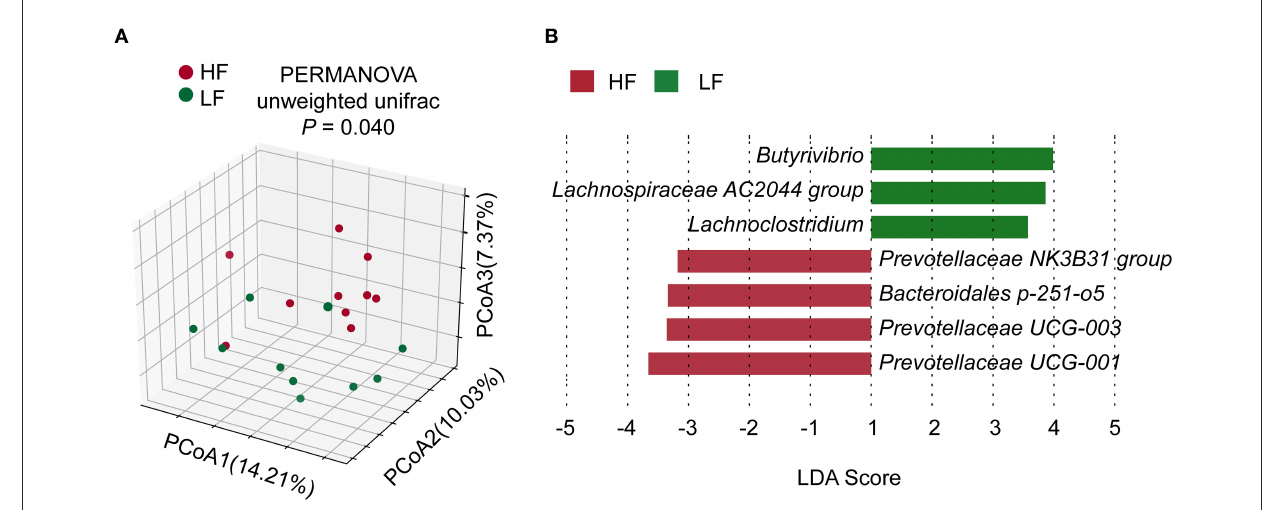
FIGURE1 (A) Comparisons of bacterial community composition. (B) LEfSe identification of biomarker genera of the groups. HF, the top 10 cows with the highest milk fat percentage; LF, the last 10 cows with the lowest milk fat percentage; LDA, linear discriminant analysis.